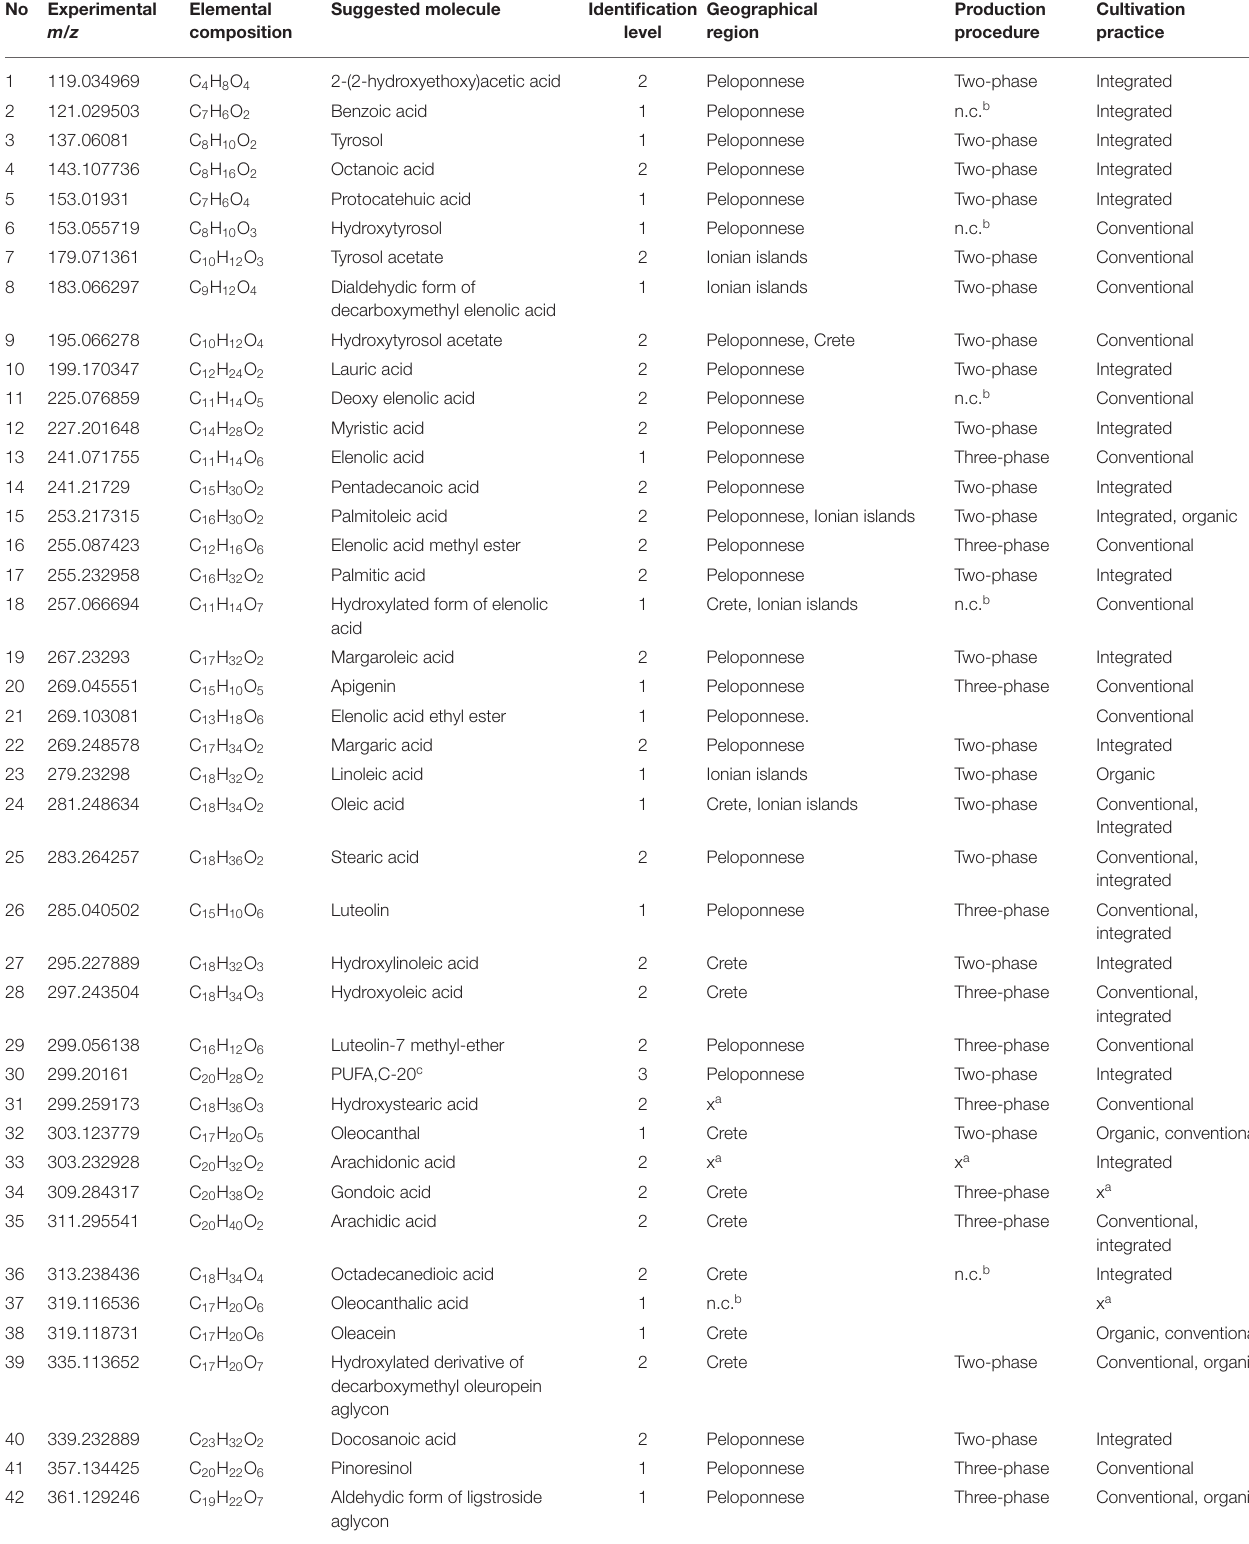
TABLE 2 | Identified metabolites in EVOO and biophenol